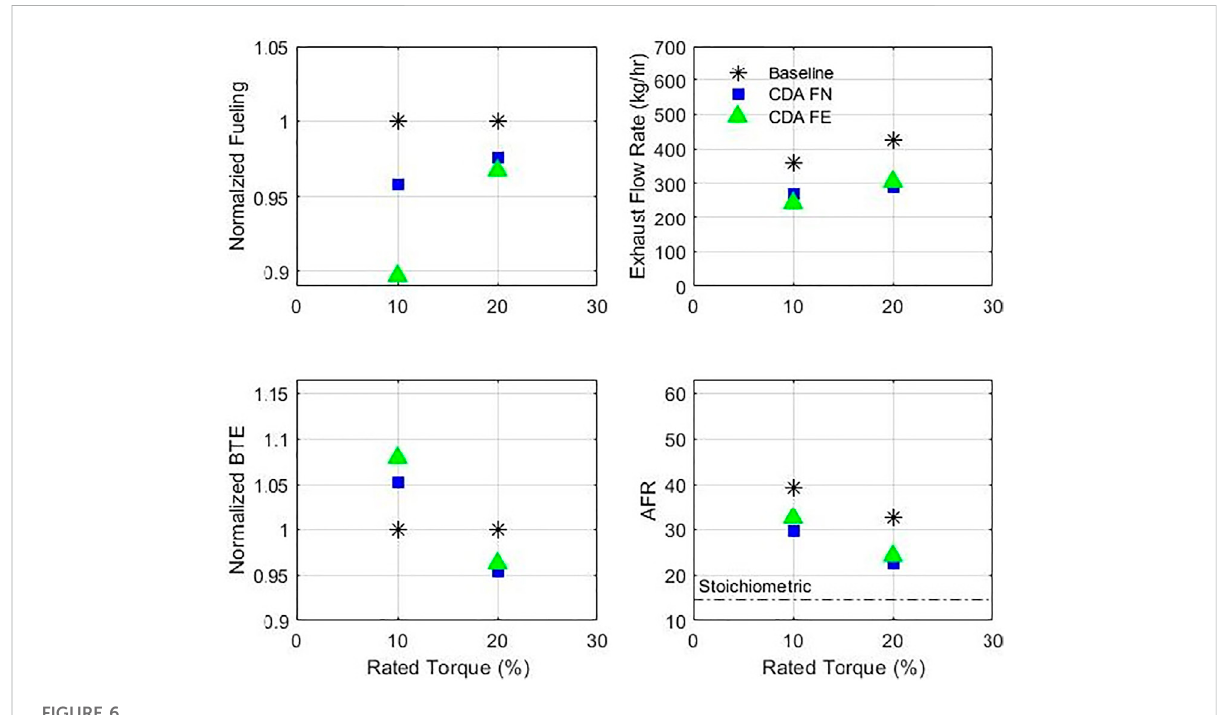
FIGURE 6 1000 rpm steady state engine